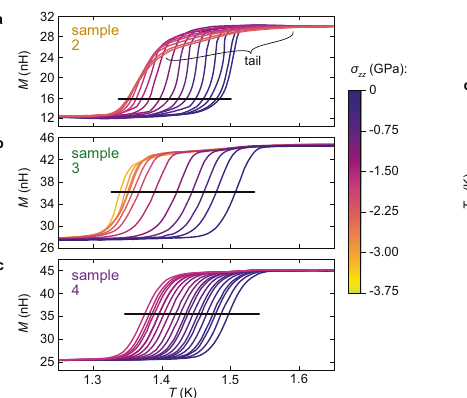
Fig.3| T c underuniaxialstress.a – c Mutualinductance M ofthesensecoilsversus temperature for samples 2 – 4, at various applied stresses σ zz . The lines indicate the selected thresholds for determination of T c . For sample 2, under large ∣ σ zz ∣ a tail appears on the transitions, which we attribute to in-plane stress, and a low